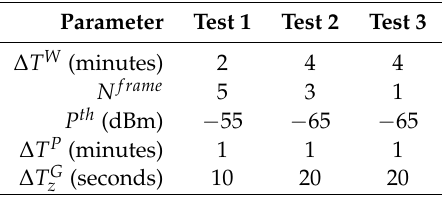
Table 6. Setting